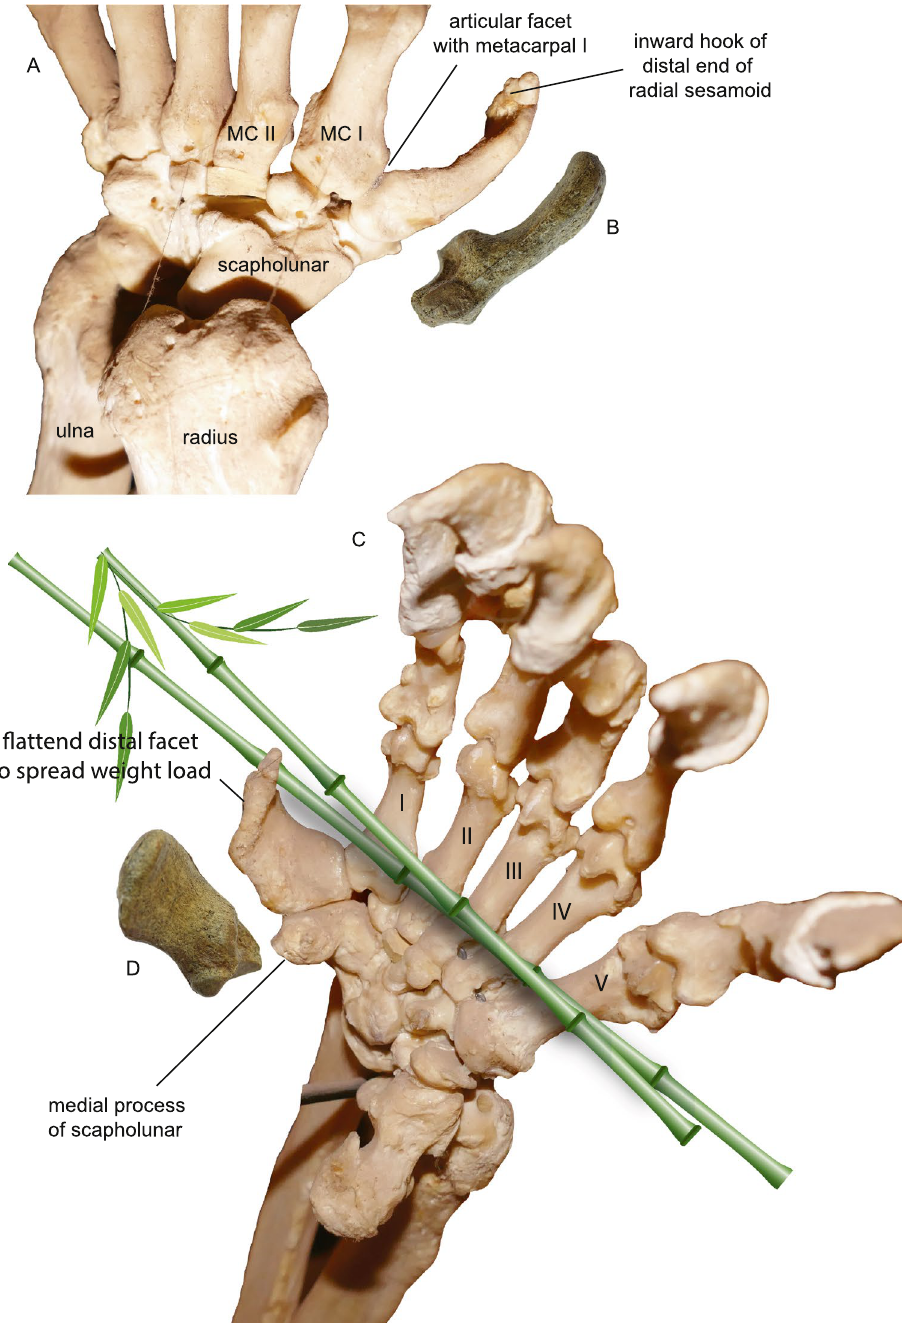
Figure 4. Giant panda’s false thumb. Dorsal ( A ) and ventral ( C ) views of the modern giant panda left hand, as compared with an isolated left radial sesamoid of Ailurarctos cf. A. lufengensis ( B and D , ZT-2015–0056) at a similar angle and relative size. Mounted skeleton of the giant panda on display at KIZ exhibition hall, probably a zoo